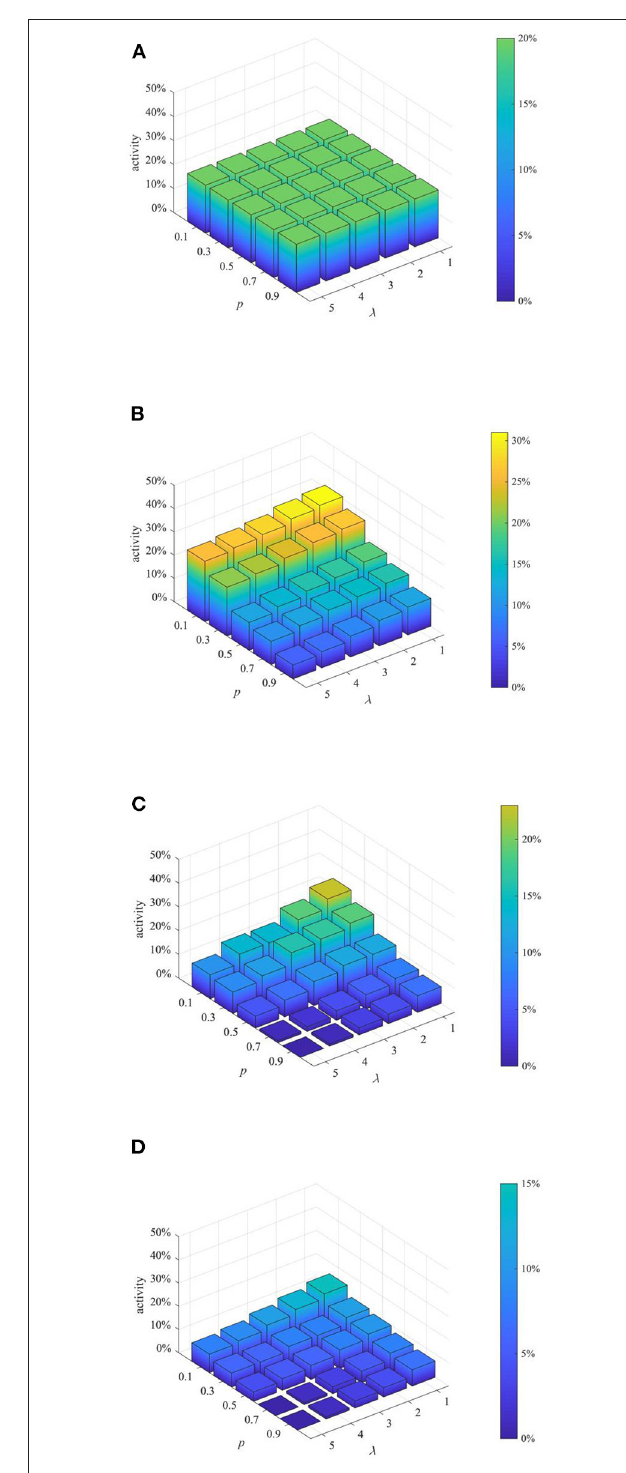
FIGURE 12 | Rumor diffusion range under different strategy combinations. (A) t = 1. (B) t = 15. (C) t = 30. (D) t = 45.